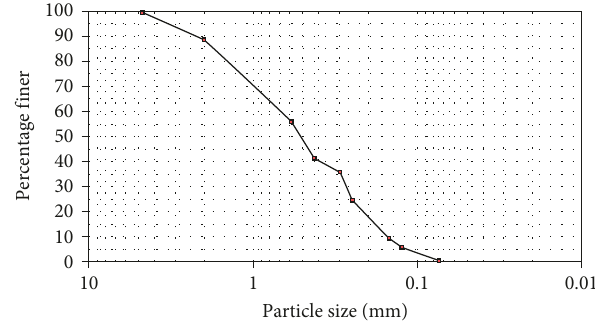
Figure 1: Grain-size distribution of the sand.